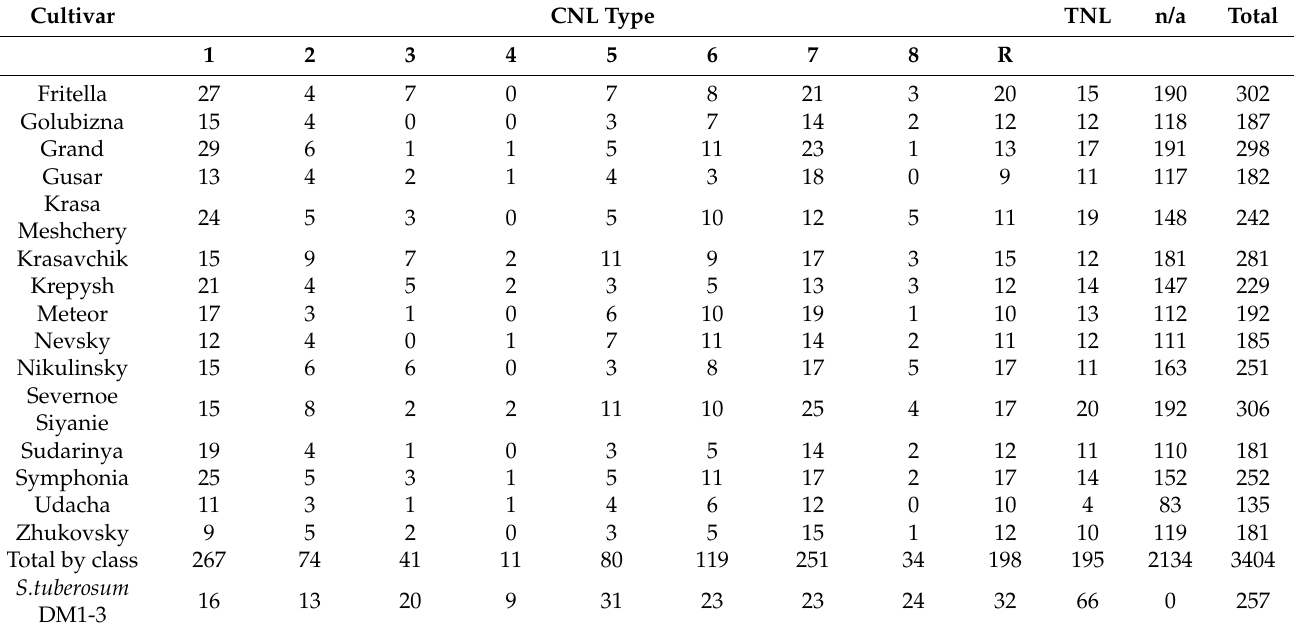
Table 4. Number of full-length NBS-LRR genes of different classes identified in genomes of Russian potato cultivars and reference genome